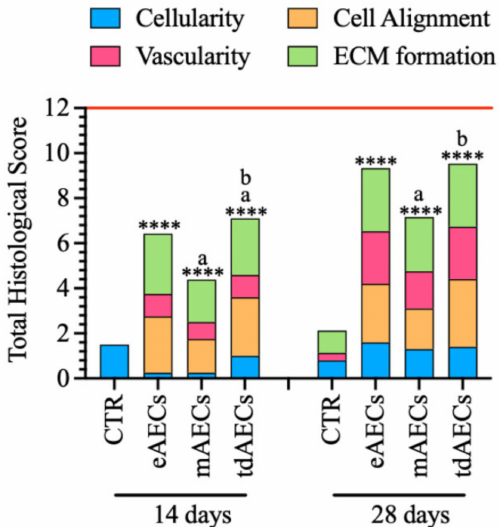
Figure 12. Stacked histograms of the semiquantitative histomorphometric score for stem-cell-treated and CTR groups at 14 and 28 days. The total histological score was compared to healthy tendon (red line) and calculated in terms of cellularity, cell alignment, vascularity, and ECM formation and structure scores (Mean). Statistically significant values were set up for **** vs. CTR ( p < 0.0001) and a vs. eAECs ( p < 0.0001) and b vs. mAECs ( p < 0.0001). The quantitative data were expressed as mean ±